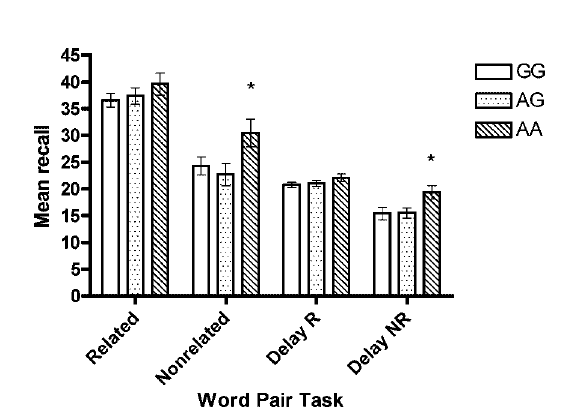
Figure 2. Mean score (SE) on word-pair task across genotype .